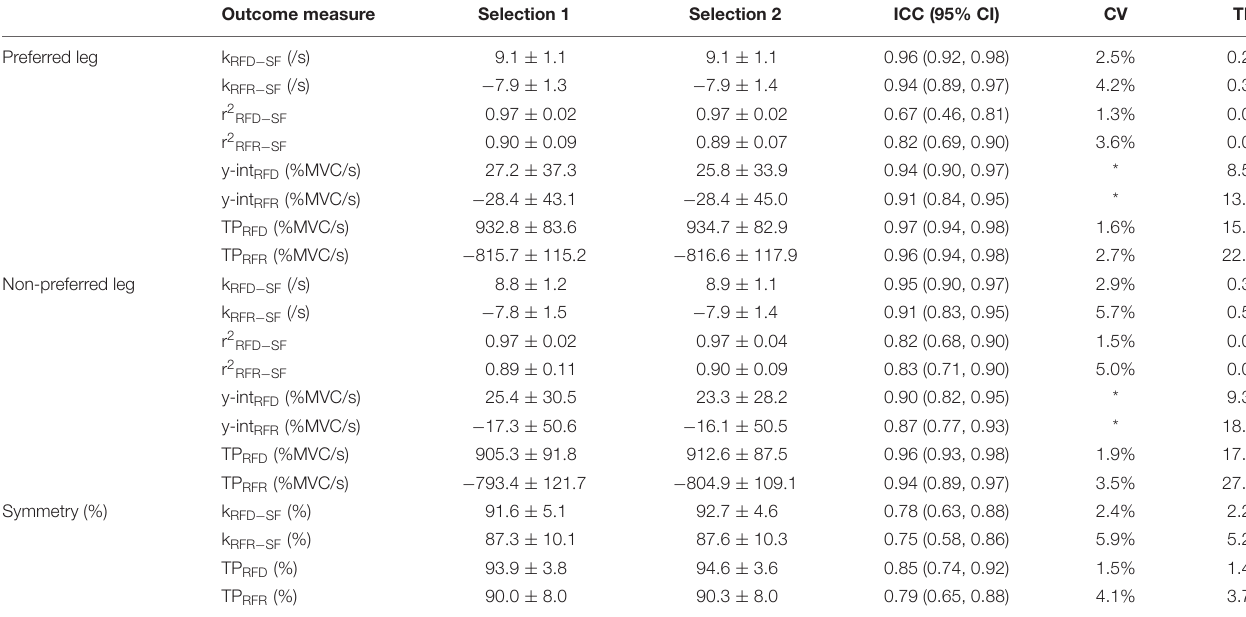
TABLE 2 | Reliability results for absolute and inter-limb symmetry main outcome measures. Outcome measure Selection 1 Selection 2 ICC (95% CI)